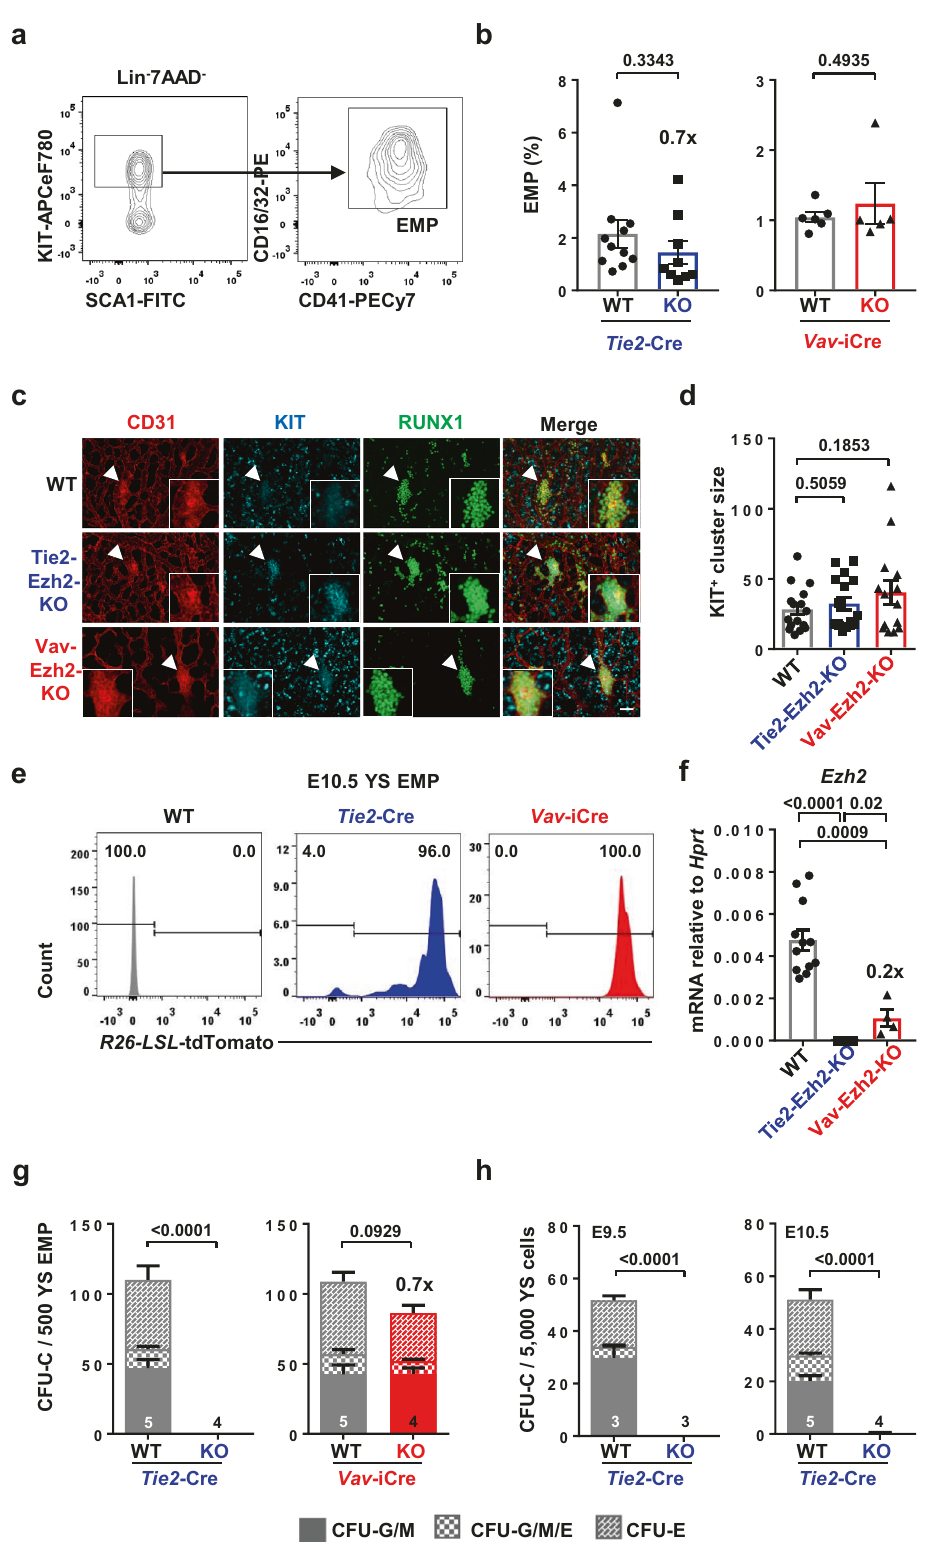
in emerging hematopoietic cells has no signi fi cant effects on global gene expression patterns in EMPs. To further dissect the molecular mechanisms regulated by Ezh2 in EMPs and to infer potential Ezh2 target genes,